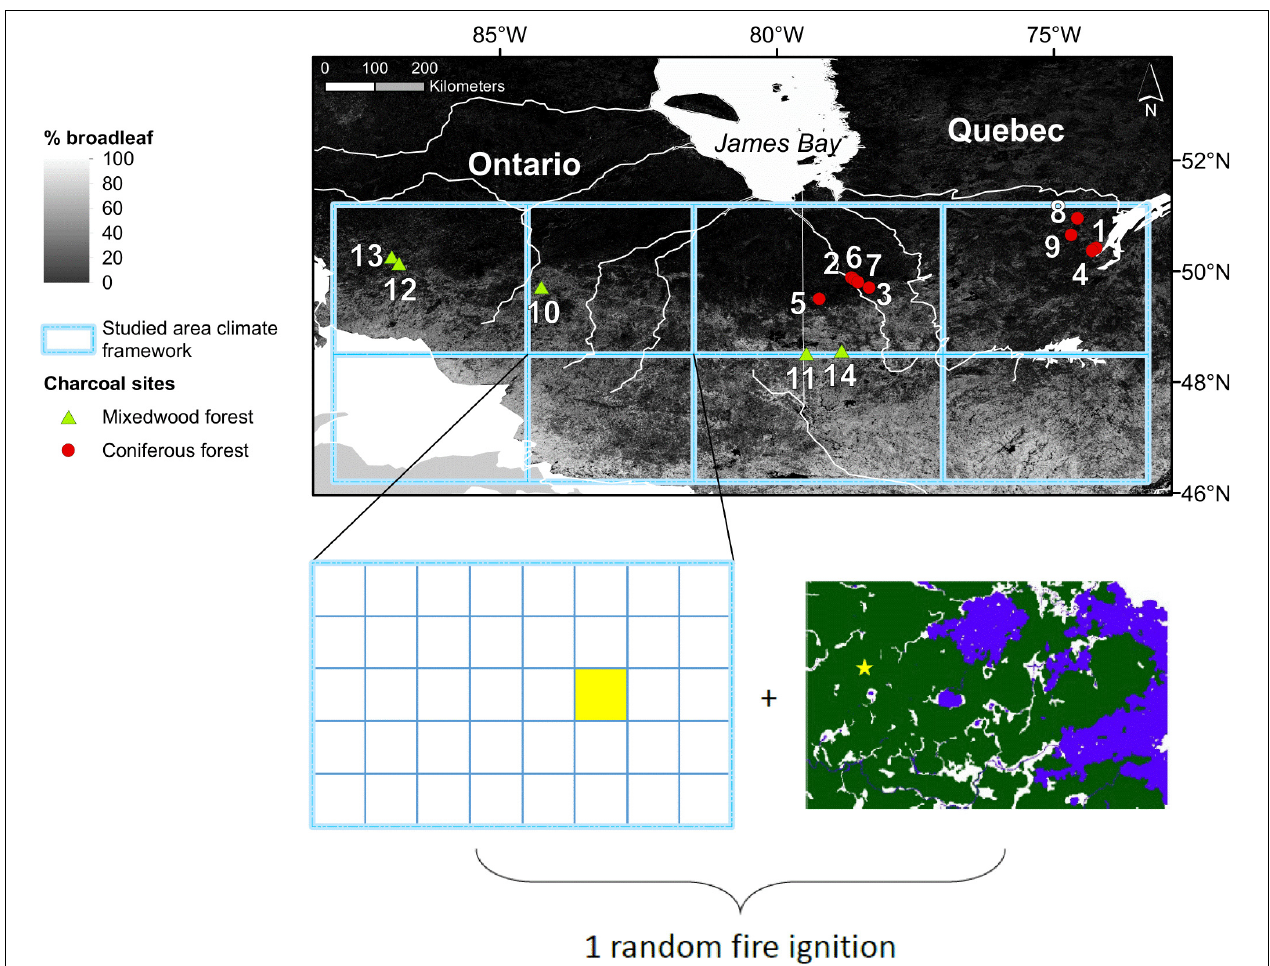
FIGURE 1 | Location of the eastern Canadian study region and its characteristics in terms of sampled lakes (triangles and circles), percentage of broadleaf tree cover [background map from Natural Resource Canada (2008)], and the climate framework (blue rectangle) used to extract Holocene climate snapshot datasets simulated by the HadCM3 climate model (Valdes et al., 2017) over the last seven millennia BP. Five lakes (green triangles) are located in the mixedwood boreal forest, south of the modern transition zone, while nine (red circles) are in the coniferous boreal forest, north of the transition zone (see Supplementary Table S1 and Supplementary Material S1 for lake and regional characteristics, respectively). We used the 48.5 ◦ N parallel (i.e., the boundary pixel nearest to 49 ◦ N from the HadCM3 climate model) in association with three meridians (77 ◦ W, 81.5 ◦ W, and 84.5 ◦ W) to split the study area (46–51 ◦ N, 73–88 ◦ W) into eight subregion replicates (blue rectangles). In each subregion, for each Holocene millennium and each forest type present in the region at that time (see Figure 2 ), we simulated a set of 120 fires, with 20 fires per month from April to October. Each fire simulated by PFAS had a random starting date in the given month, a random projection time-length